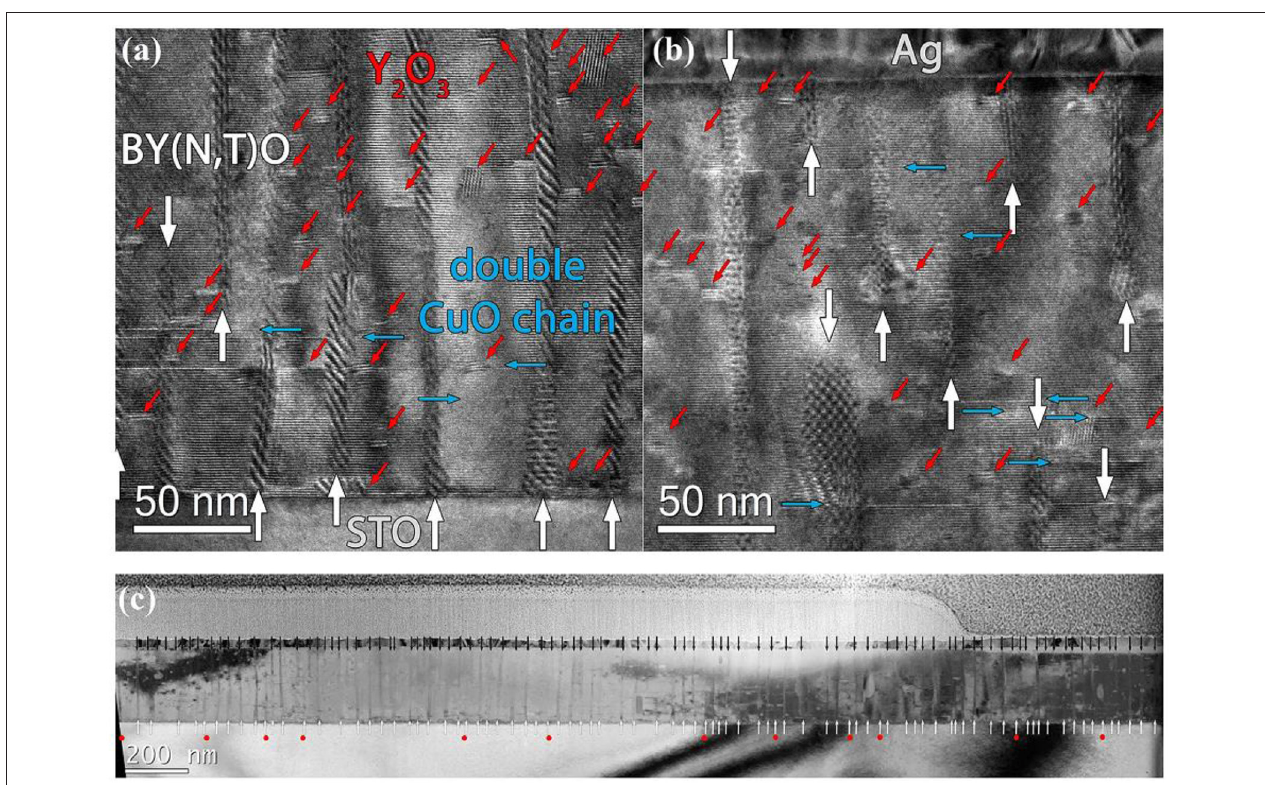
FIGURE 10 | High-resolution TEM images of YBCO:YBNTO (YBCO (a) and near the film surface (b) . Different pinning centers such as YBNTO nanocolumns, Y 2 O 3 nanoparticles and planar defects are marked. (c) Bright-field TEM cross-sectional image of the 1Hz sample over larger width (3,200nm). YBNTO nanocolumns are marked with arrows. The nanocolumns which are tilted are marked by red dots. Reproduced from Opherden et al.